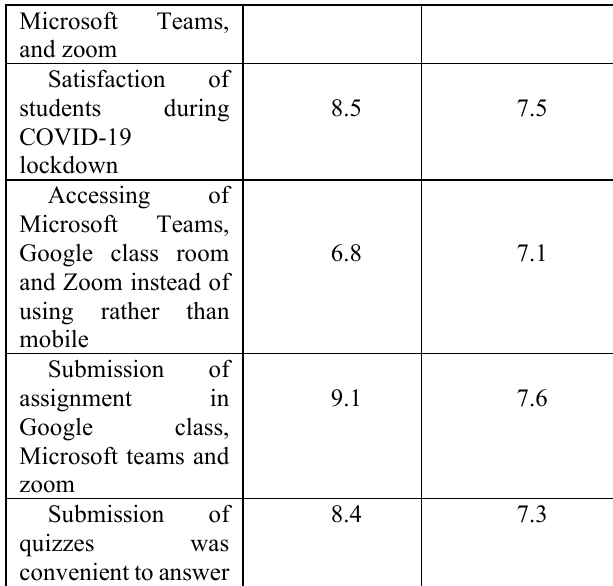
Table 7. Teachers responses to the survey of